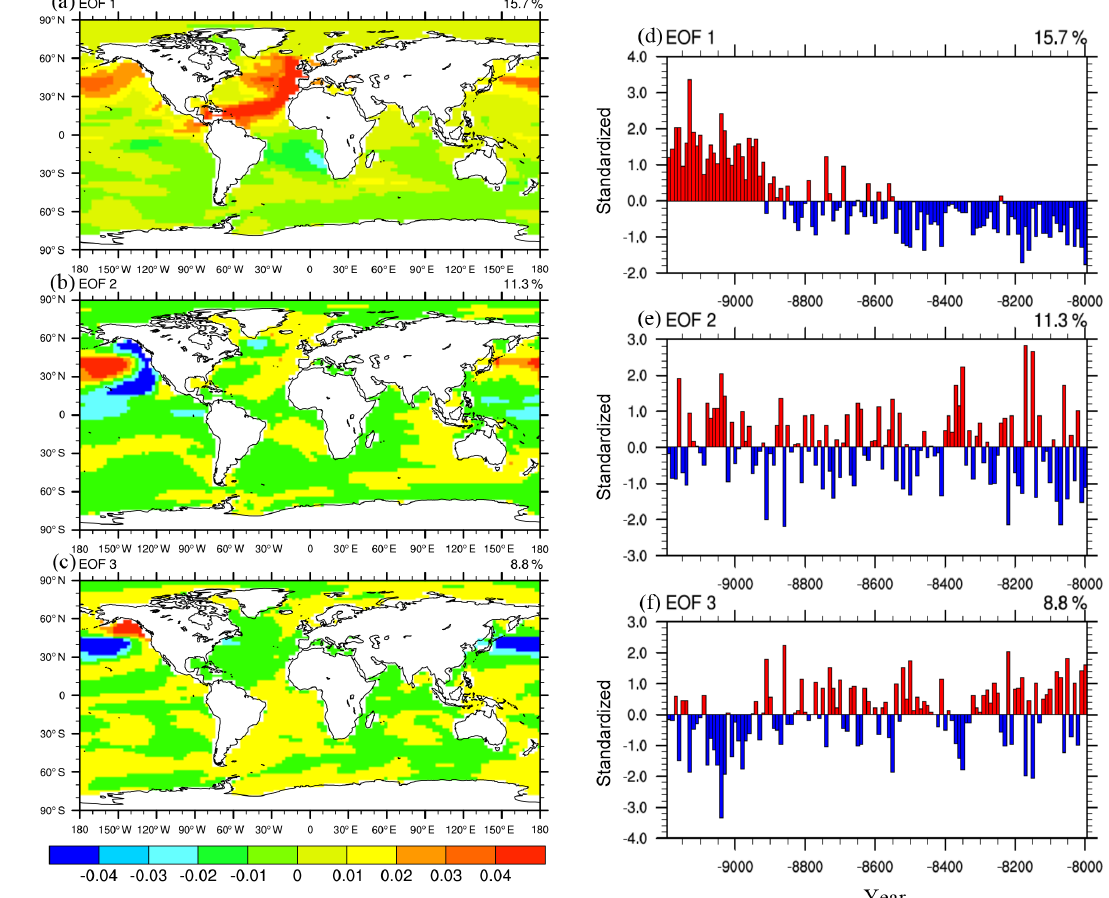
Figure 5. The first three patterns (a–c) and principal components (d–f) of rotated EOF modes on the SST over the period 9200–8000BP.